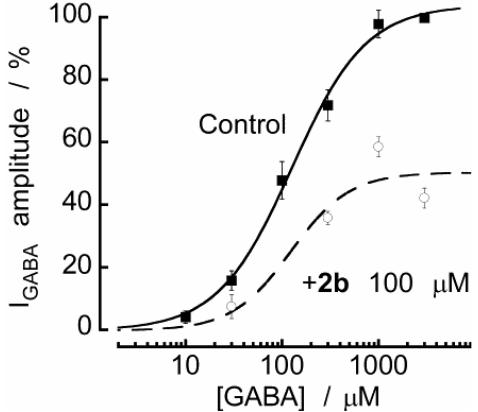
Figure 7. 2b inhibits I in a non-competitive manner. ( A ) Concentration–response GABA curves for GABA in the absence (Control) and in the presence of 2b . Responses were normalized with respect to the curves obtained in the presence of 3 mM GABA in each cell and in the absence of 2b . Each point represents the mean ± SEM for 5–12 neurons. The lines indicate fits of experimental data to a three-parameter logistic